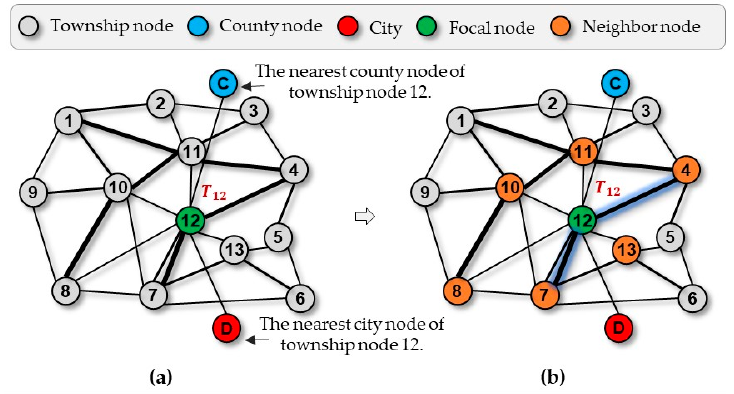
Figure 6. Calculation model of township hub level: ( a ) Road connectivity-based township network that contains cities and counties; ( b ) Focal township node and its neighbor nodes.